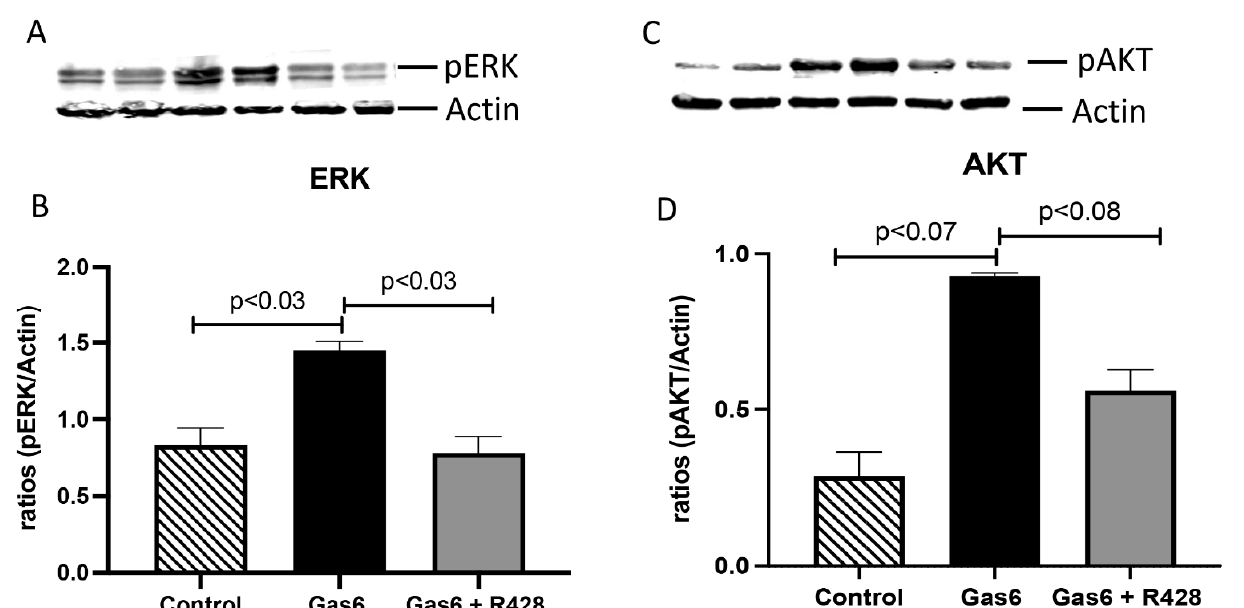
Figure 4. Lung-signaling molecules in control and treated animals. A representative Western blot for ERK and Akt is shown in ( A , C ). Lung levels of ERK ( B ), and AKT ( D ) were increased in Gas6-treated animals compared to controls (n = 6 per group). Molecules were deceased in animals co-treated with R428. Representative data are shown with p ≤ 0.05.